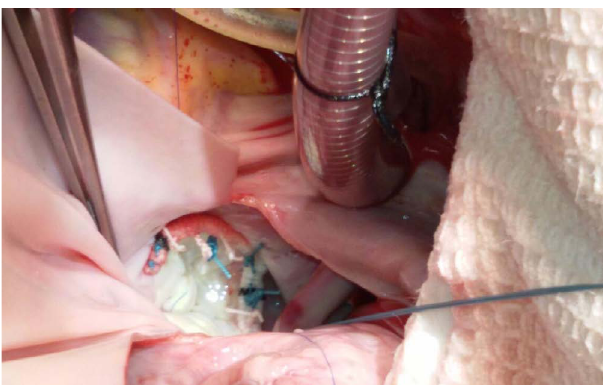
Fig. 2 – Competent mitral valve on saline testing after mitral